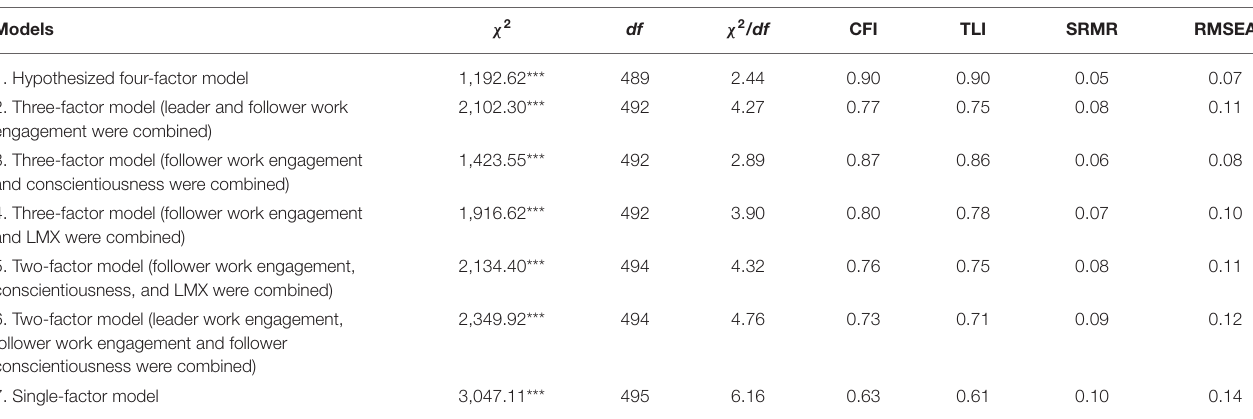
TABLE 2 | Measurement model